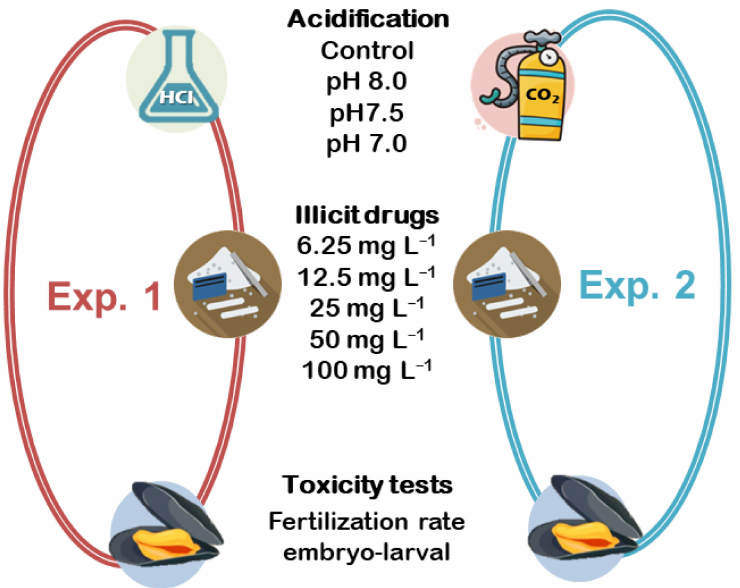
Figure 1. Schematic design of toxicity tests carried out in the study: HCl ( left ) and CO 2 ( right ) injection acidification. Simplified parameters selected for experiment 1 and 2 with acidification sources (CO 2 and HCl), crack concentrations (6.25, 12.5, 25, 50 and 100 mg L − 1 ) and the targeted endpoints for mussels (fertilization rate and embryo larval